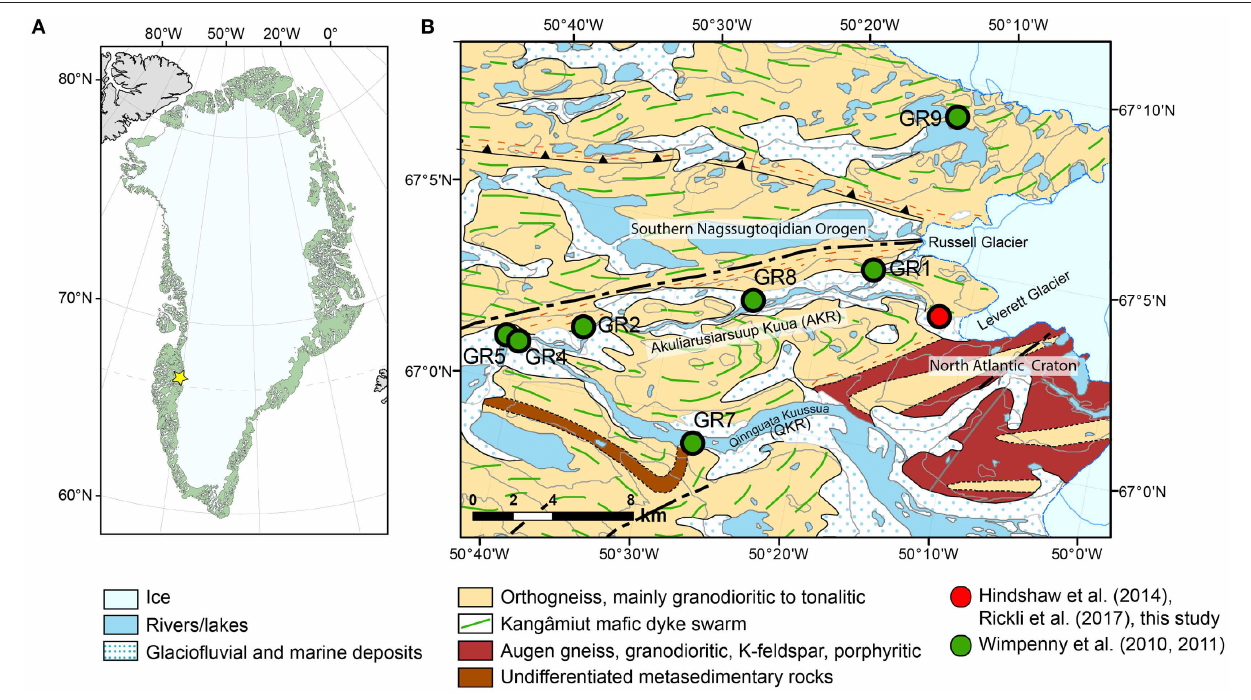
FIGURE 1 | (A) The study site is indicated by a yellow star. (B) Geological map of the Kangerlussuaq area of West Greenland. The location of the time series of water samples from the river draining Leverett Glacier analyzed in this study is marked as a red circle. River sediment and rock samples were also collected at this location. The water samples with a glacier contribution, bedload, suspended sediment, and bedrock samples analyzed by Wimpenny et al. (2010, 2011) are marked as green circles together with their sample names (GR1–GR9). Watson River refers to the river after the confluence of the Qinnguata Kuussua and Akuliarusiarsuup Kuua rivers. Geological basemap from Geological Survey of Denmark and Greenland, and Ministry of Mineral Resources under the Government of Greenland. Datum and projection: WGS84 UTM Zone